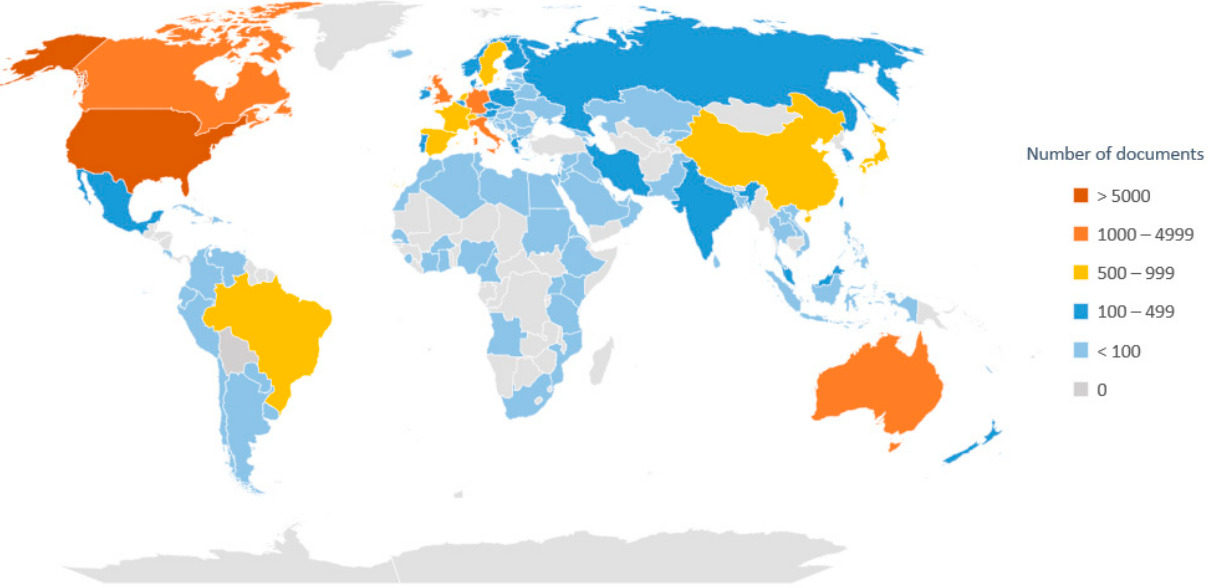
Figure 4. Ranges in the number of documents published by country on the subject of “healthy aging” according to Scopus (2011–2020).